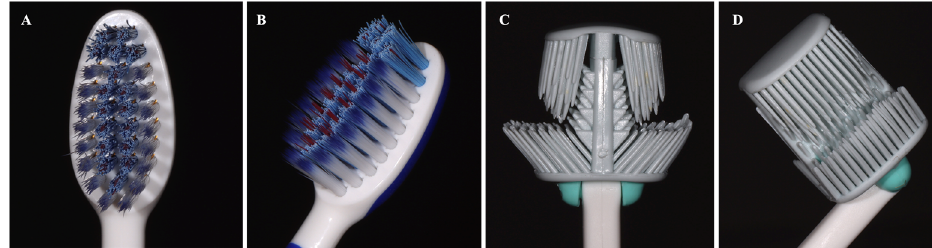
Figure 1. Photographs of control ( A , B ) and test ( C , D ) toothbrush heads.